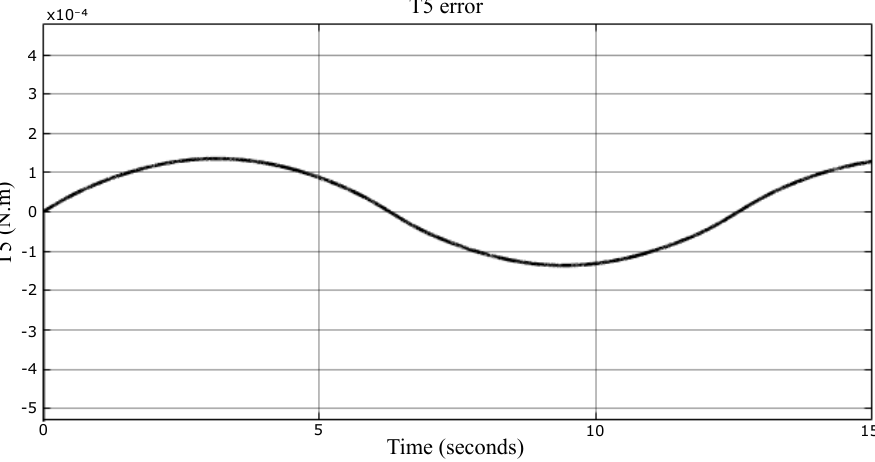
Figure 28. Torque error signal of the fifth